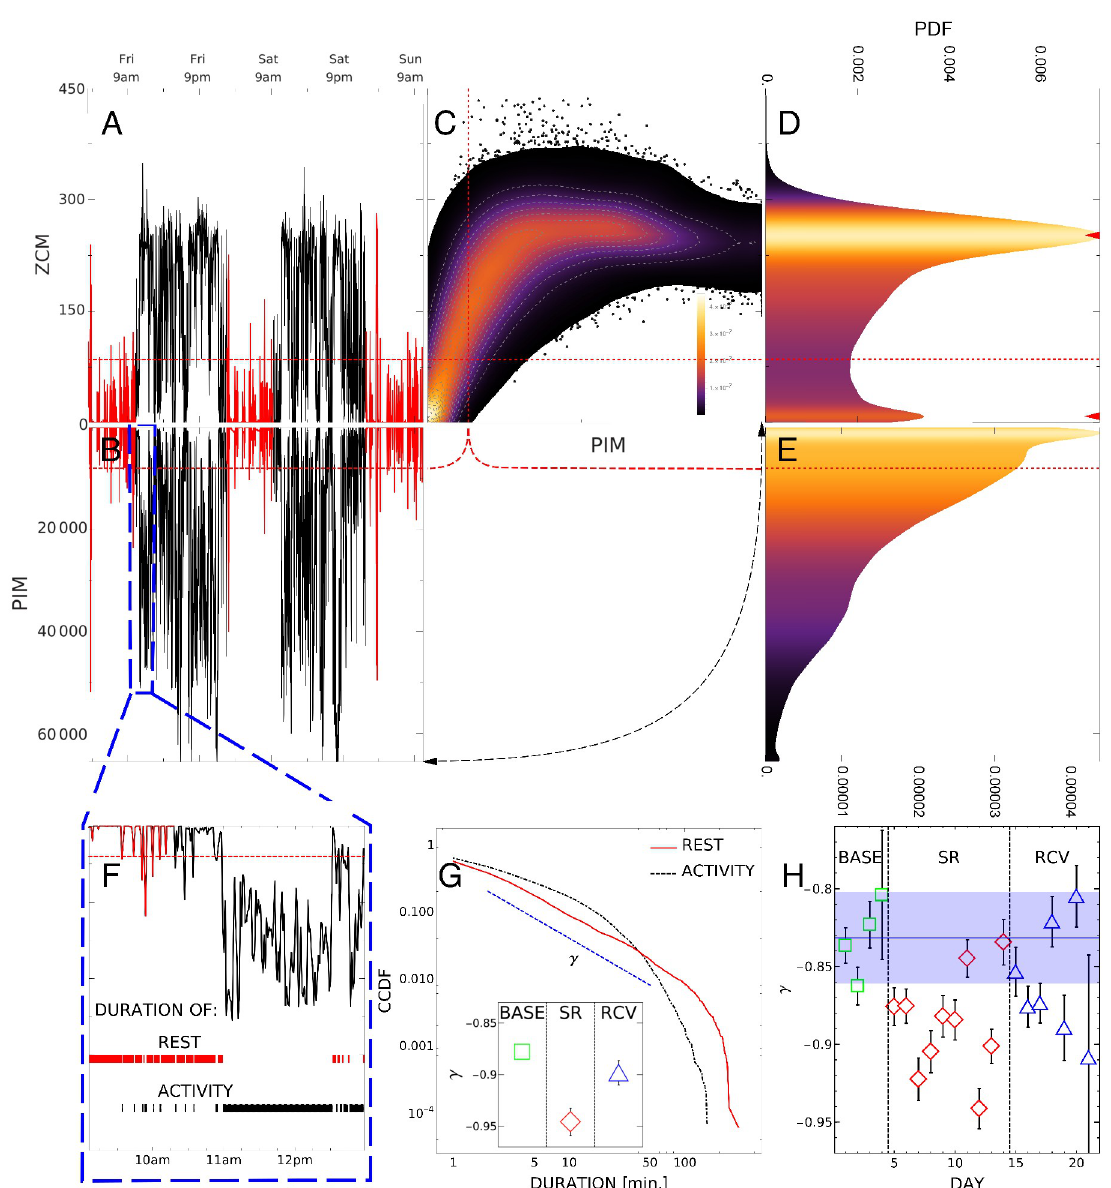
Fig 2. Summary of actigraphy analysis. A-B: a sample of the first two days (black) and three nights (red) of activity recording of a single subject in ZCM and PIM modes. C: density histogram of ZCM versus PIM activity (vertical and horizontal axes, respectively) collected from all subjects on all days (BASE, SR, and RCV) with the highest concentration of data around point (0, 0); the relation between ZCM and PIM is non-linear with ZCM saturating around 250. D-E: separate histograms of ZCM and PIM recordings, respectively; ZCM has two peaks, at 8 and 252, marked by red triangles corresponding to diurnal and nocturnal activity, while PIM is unimodal. F: rest and activity periods (red and black stripes) are defined as segments of activity continuously smaller or greater than a threshold (red dashed line); lengths of these segments are collected into duration distributions in G. G: complementary cumulative distributions of rest and activity durations in SR period of all subjects in log-log scale; γ is the exponent of power-law tail of rest CCDF (slope of the blue dashed line). Inset: γ exponents in baseline, sleep restriction and recovery conditions. H: γ exponents for each day of the experiment obtained from rest duration CCDF of all